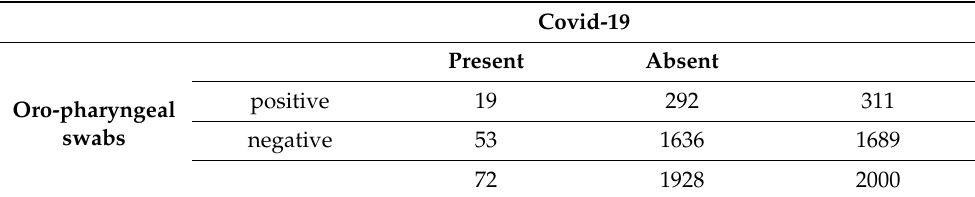
Table A5. Prevalence of COVID-19 equal to 0.36% with sensibility equal 27% and specificity equal 84.9%.